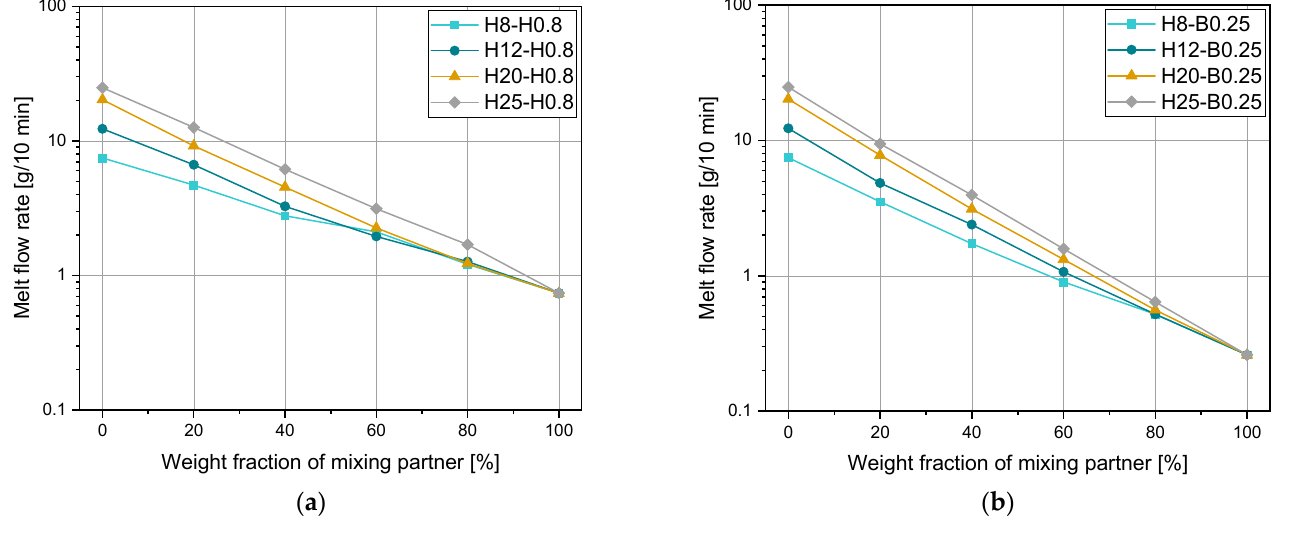
Figure 1. Melt flow rate depending on the weight fraction of ( a ) H0.8 and ( b ) B0.25 for H8, H12, H20, and H25.